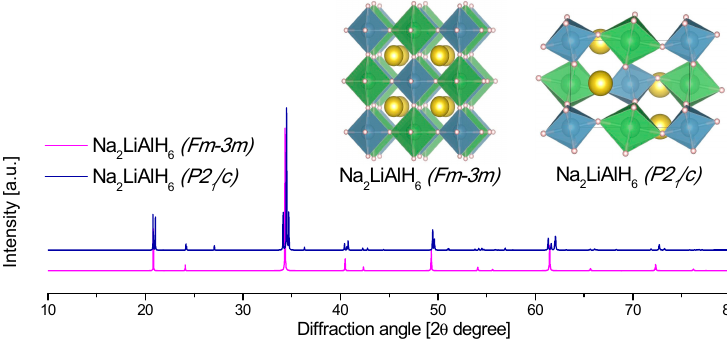
Figure 21. Crystal structure of Na-Li alanate and its calculated diffraction patterns ( λ = Cu k α 1 ).